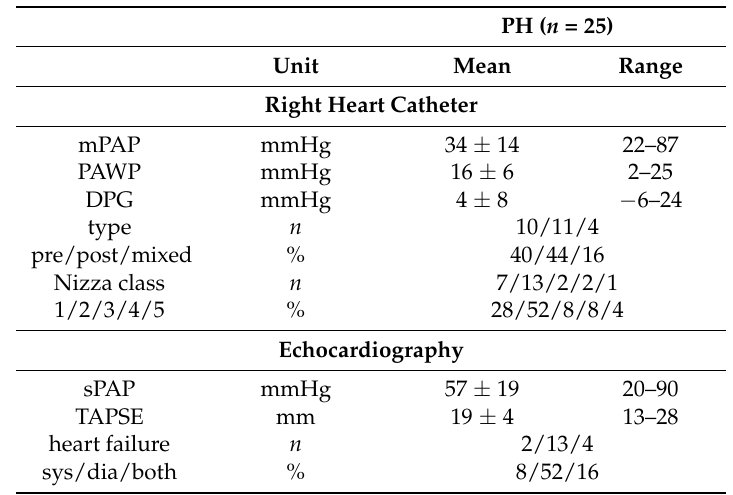
Table 3. Hemodynamic data.